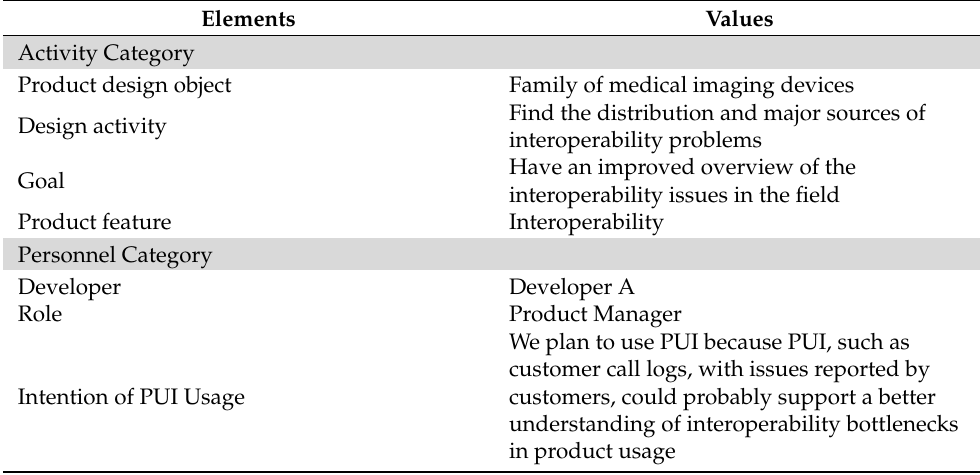
Table 3. Healthcare scenario: summary of the elements the activity category and personnel category.